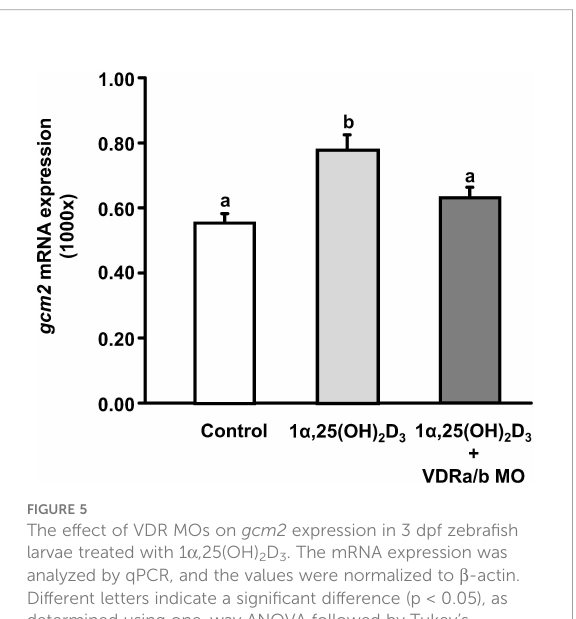
FIGURE 5 The effect of VDR MOs on gcm2 expression in 3 dpf zebra fi sh larvae treated with 1 a ,25(OH) 2 D 3 . The mRNA expression was analyzed by qPCR, and the values were normalized to b -actin. Different letters indicate a signi fi cant difference (p < 0.05), as determined using one-way ANOVA followed by Tukey ’ s multiple-comparison test. Values were expressed as the mean ± SEM (n =